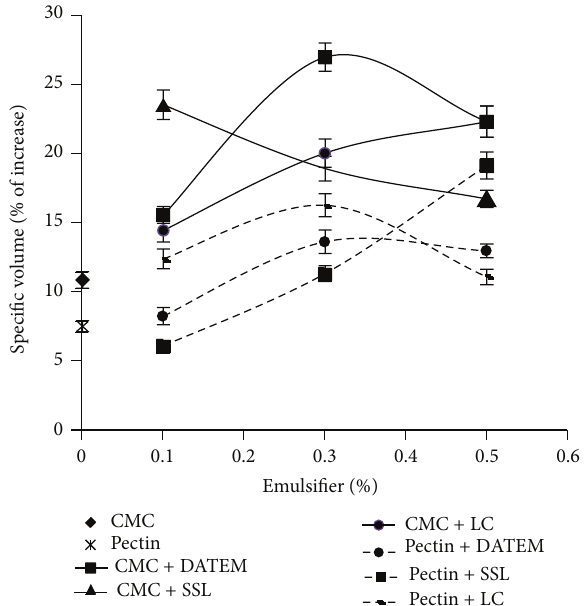
Figure 1: Specific volume increase (%) due to hydrocolloids CMC and pectin at a level of 3% and emulsifier types (DATEM, SSL, and LC) at different levels of addition. The error bars represent the standard